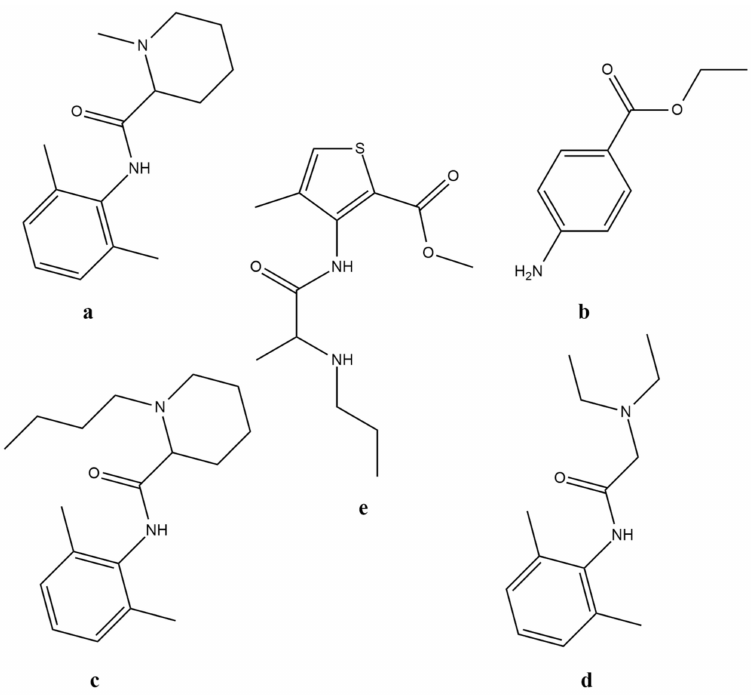
Figure 1. Chemical structures of the most common local anesthetics: mepivacaine ( a ), benzocaine ( b ), bupivacaine ( c ), lidocaine ( d ) and articaine ( e